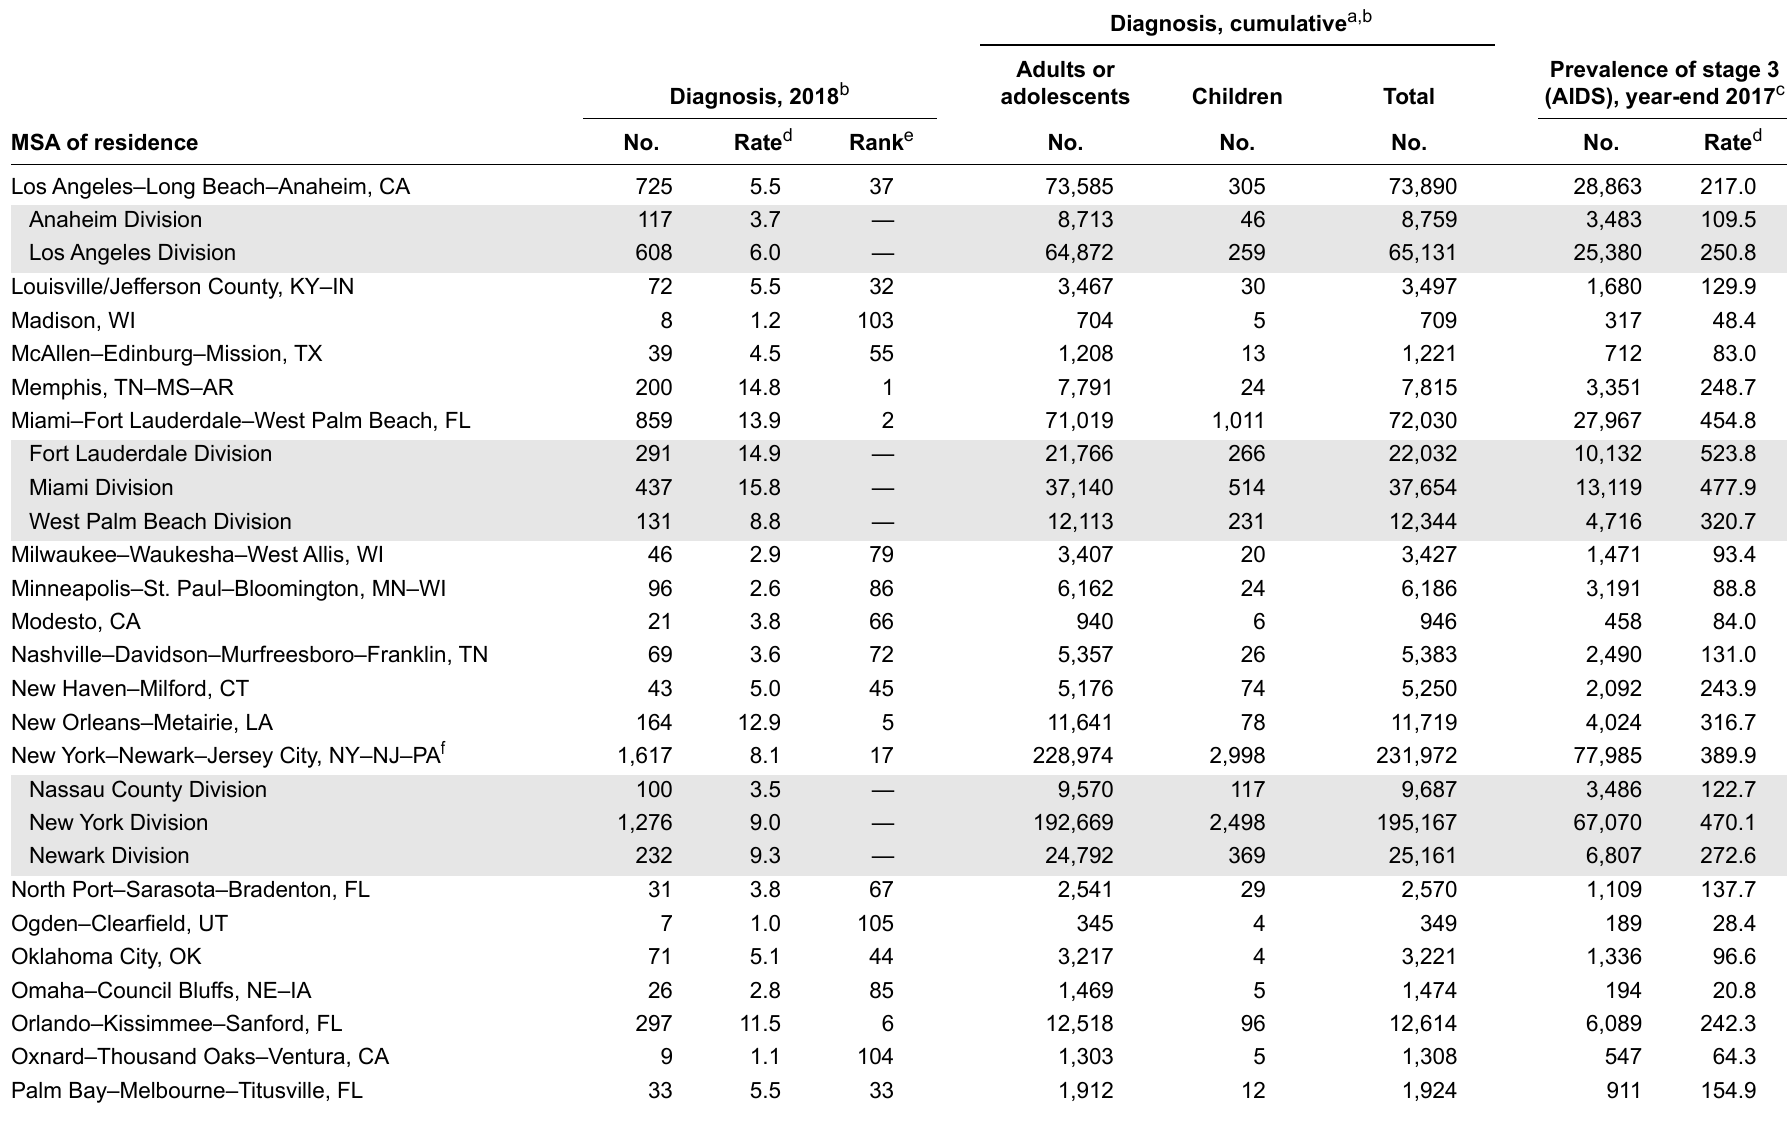
Table 31. Stage 3 (AIDS), 2018 and cumulative, and persons living with diagnosed HIV infection ever classified as stage 3 (AIDS) (prevalence), year-end 2017, by metropolitan statistical area of residence—United States and Puerto Rico